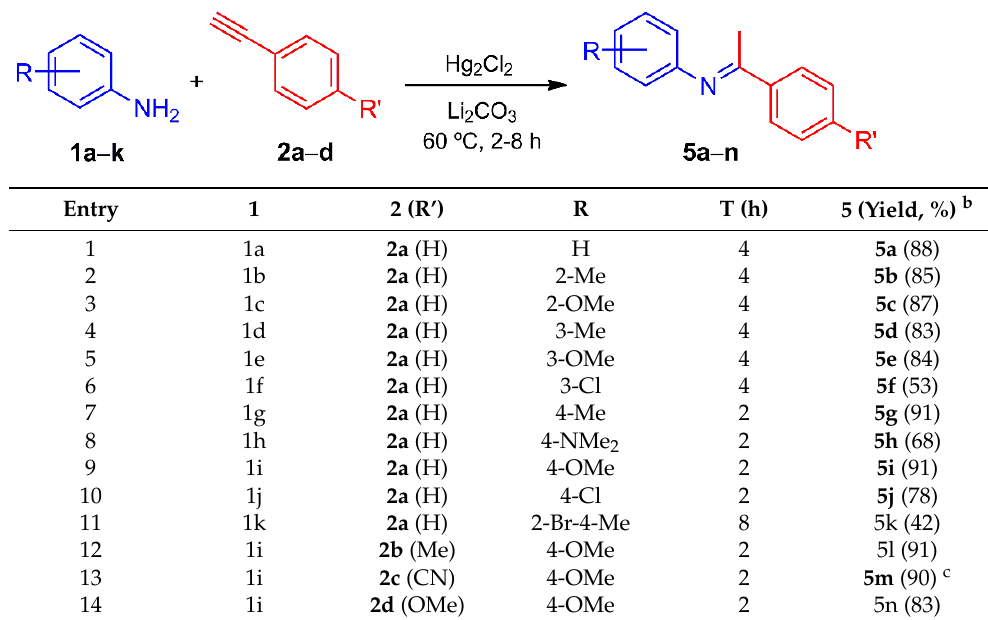
Table 2. Preparation of the series of N -arylimines 5a – n through the Hg(I)-catalyzed hydroamination of 2a – d with anilines 1a – k a .